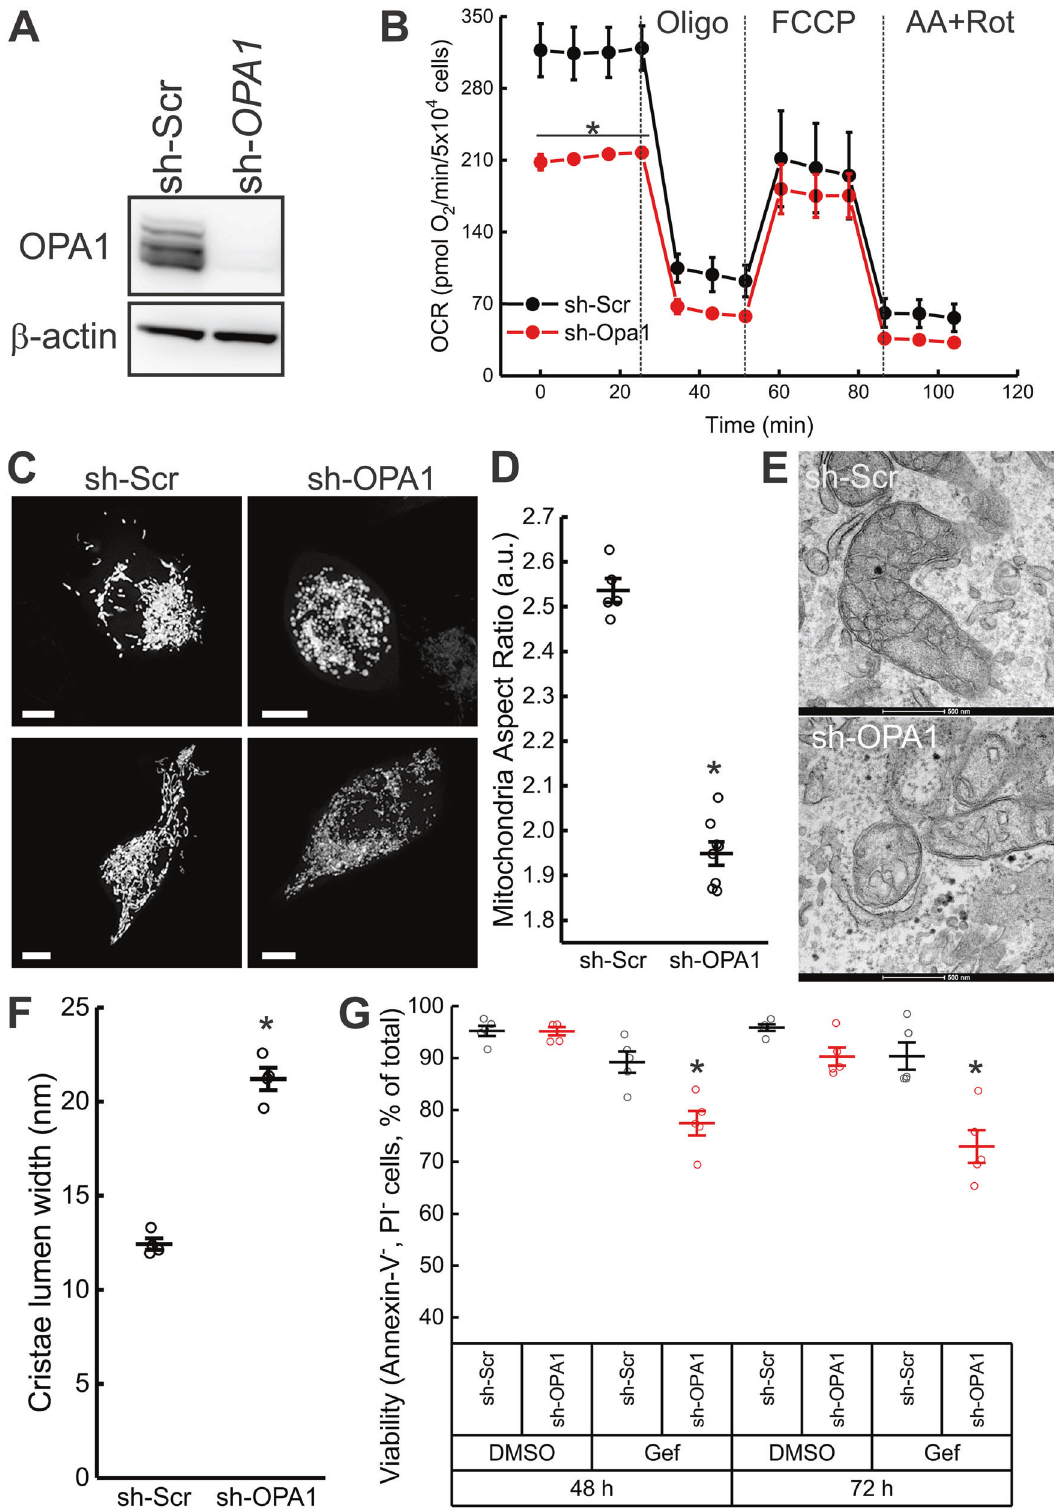
Because our cell biology and bioinformatic data suggested a role for Opa1 in the phenotype of the ge fi tinib-resistant PC9M2 cells as well as in de fi ning prognosis of chemotherapy-treated LUAD patients, we decided to investigate whether genetic